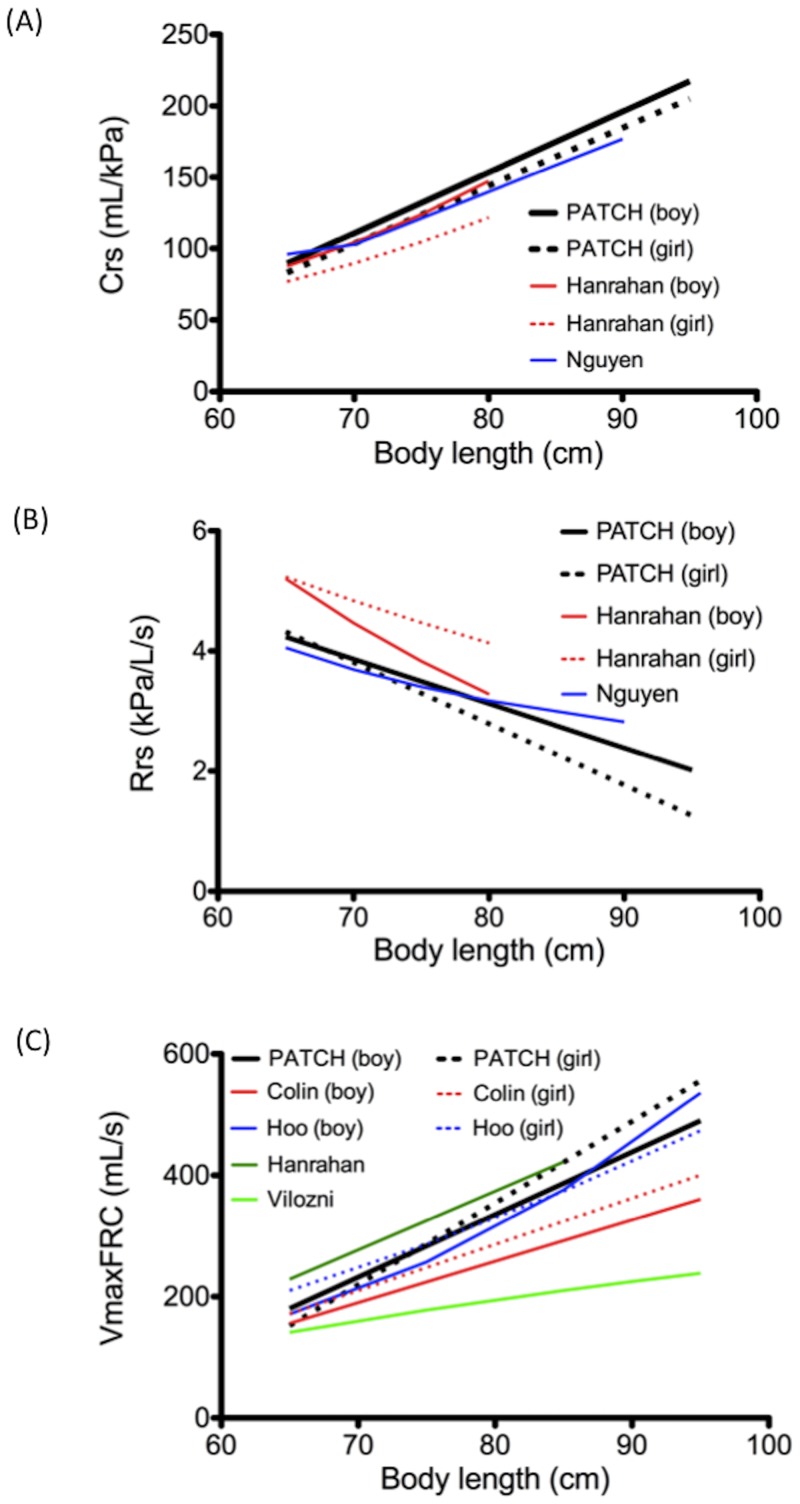
Comparison of various reference curves.Present regressions of (A) Crs, (B) Rrs, and (C) VmaxFRC in this study compared with previously published data.